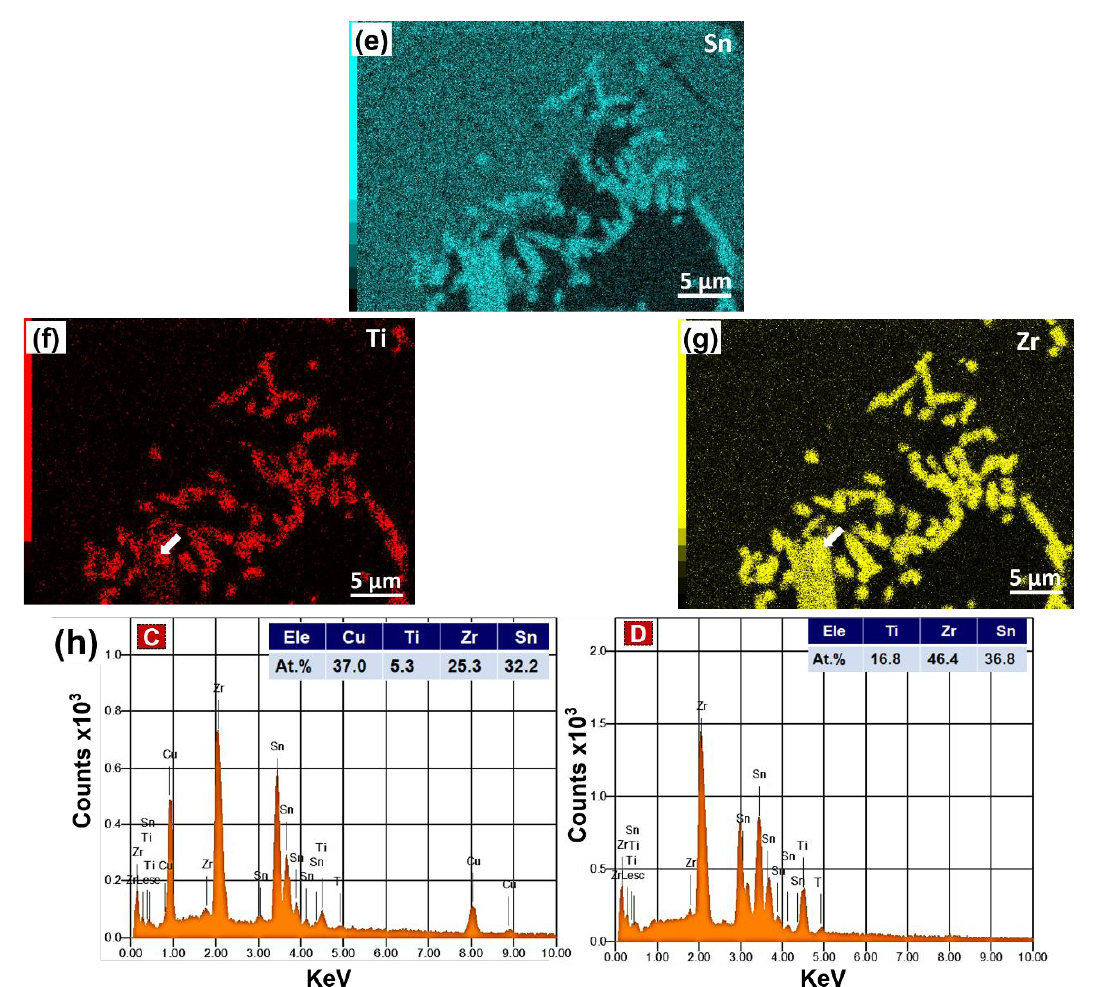
Figure 3. ( a ) Microstructure of Ag-18Cu-6Sn-3Zr-1Ti brazing filler; ( b ) magnified microstructure ( c – g ) elemental mapping corresponding to ( b ), displaying Ag, Cu, Sn, Ti and Zr, respectively; and ( h ) EDS analysis of spot C and D in ( b ).